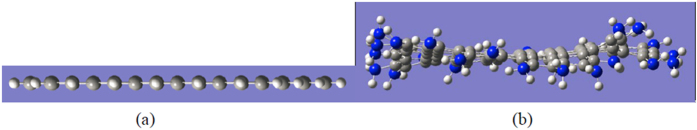
Optimized molecular structures.(a) GQD and (b) SF-GQD with -NH2.